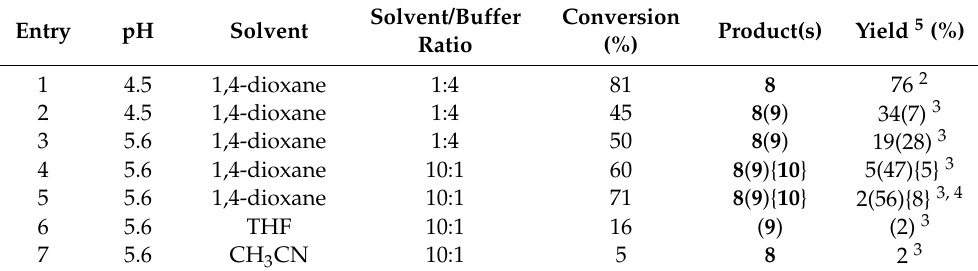
Table 1. Laccase-catalyzed 1,4-dioxane-mediated synthesis of belladine N -oxide derivative 9 start- ing from 7b . 1